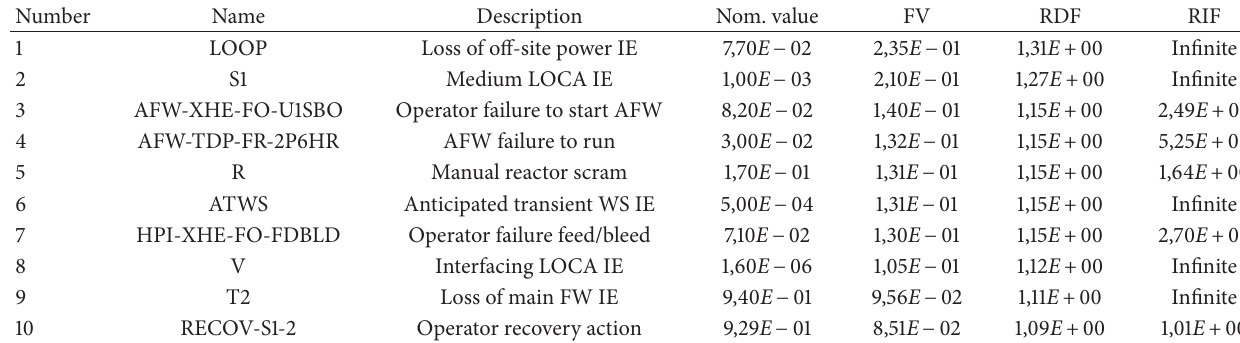
Table 10: Basic events with the largest FV importance measure, model with 15-minute delay.